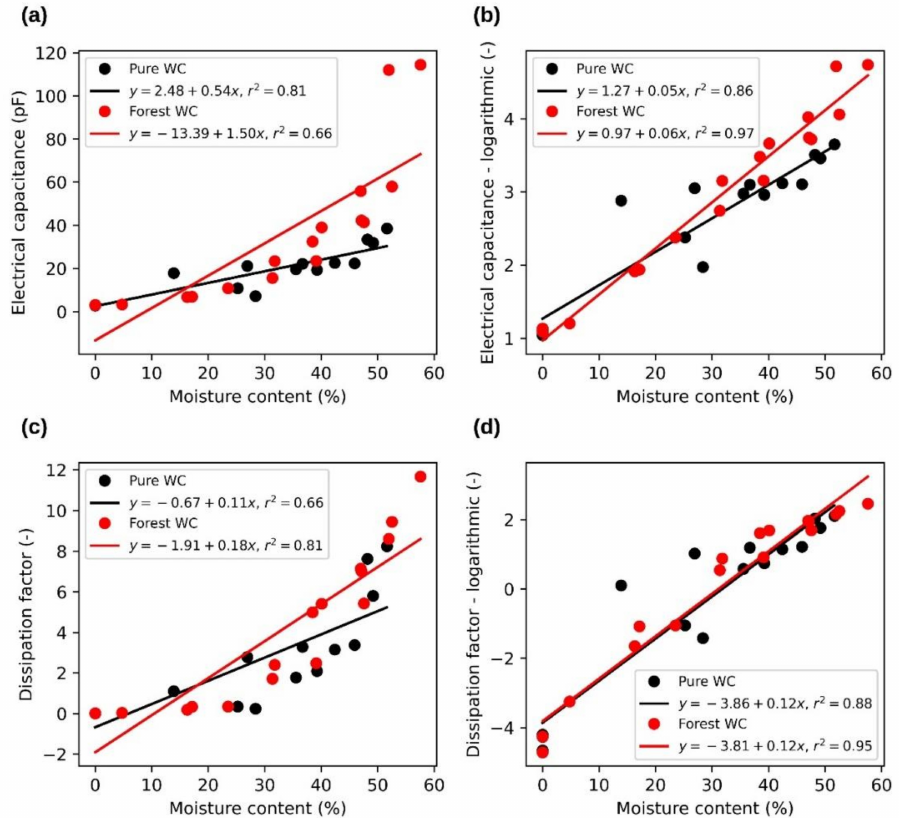
Figure 6. Relationships between wood chip moisture content and dielectric properties at 100